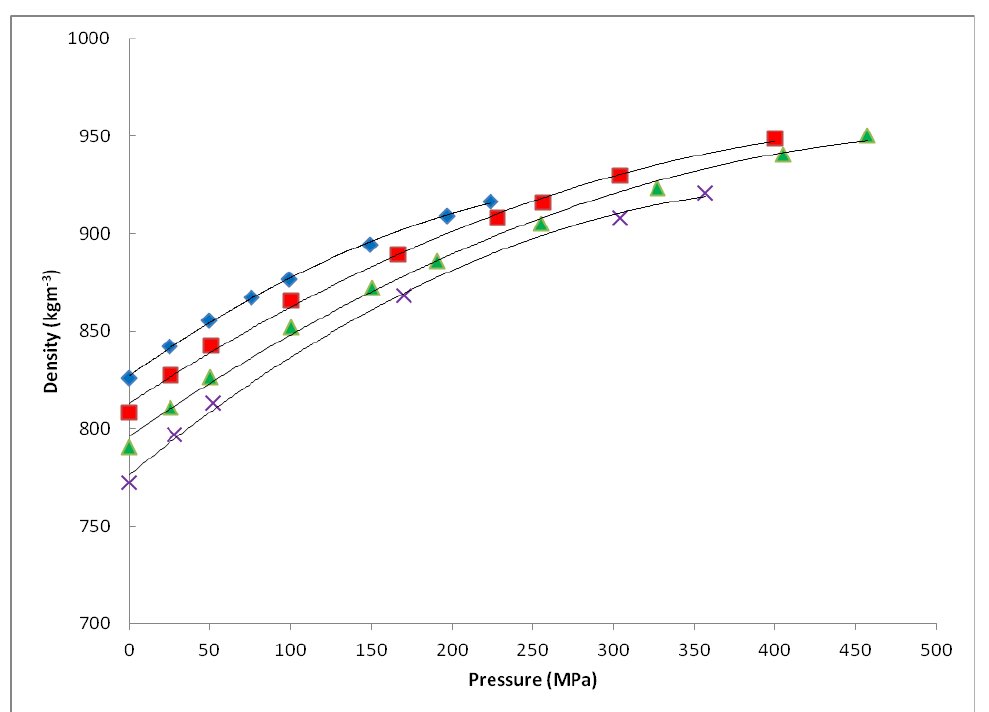
Figure 3. Variation of density for Fuel 1 with temperature. ♦ 298 K, ■ 323 K, ▲ 348 K, and X 373